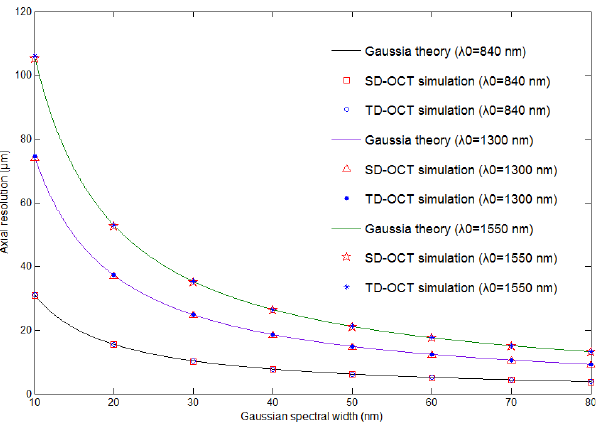
Fig. 11. The axial resolution of the simulated SD- and TD- OCT